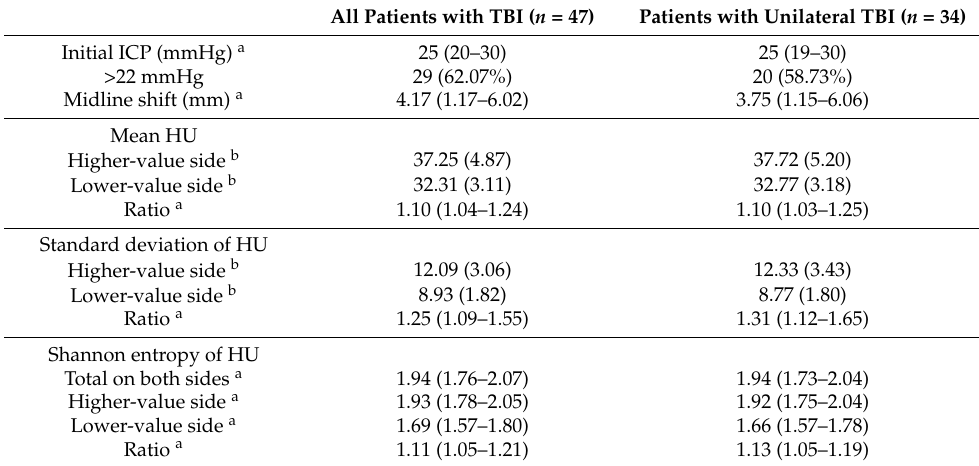
Table 1. Initial ICP- and CT-related characteristics of participants. All Patients with TBI ( n =